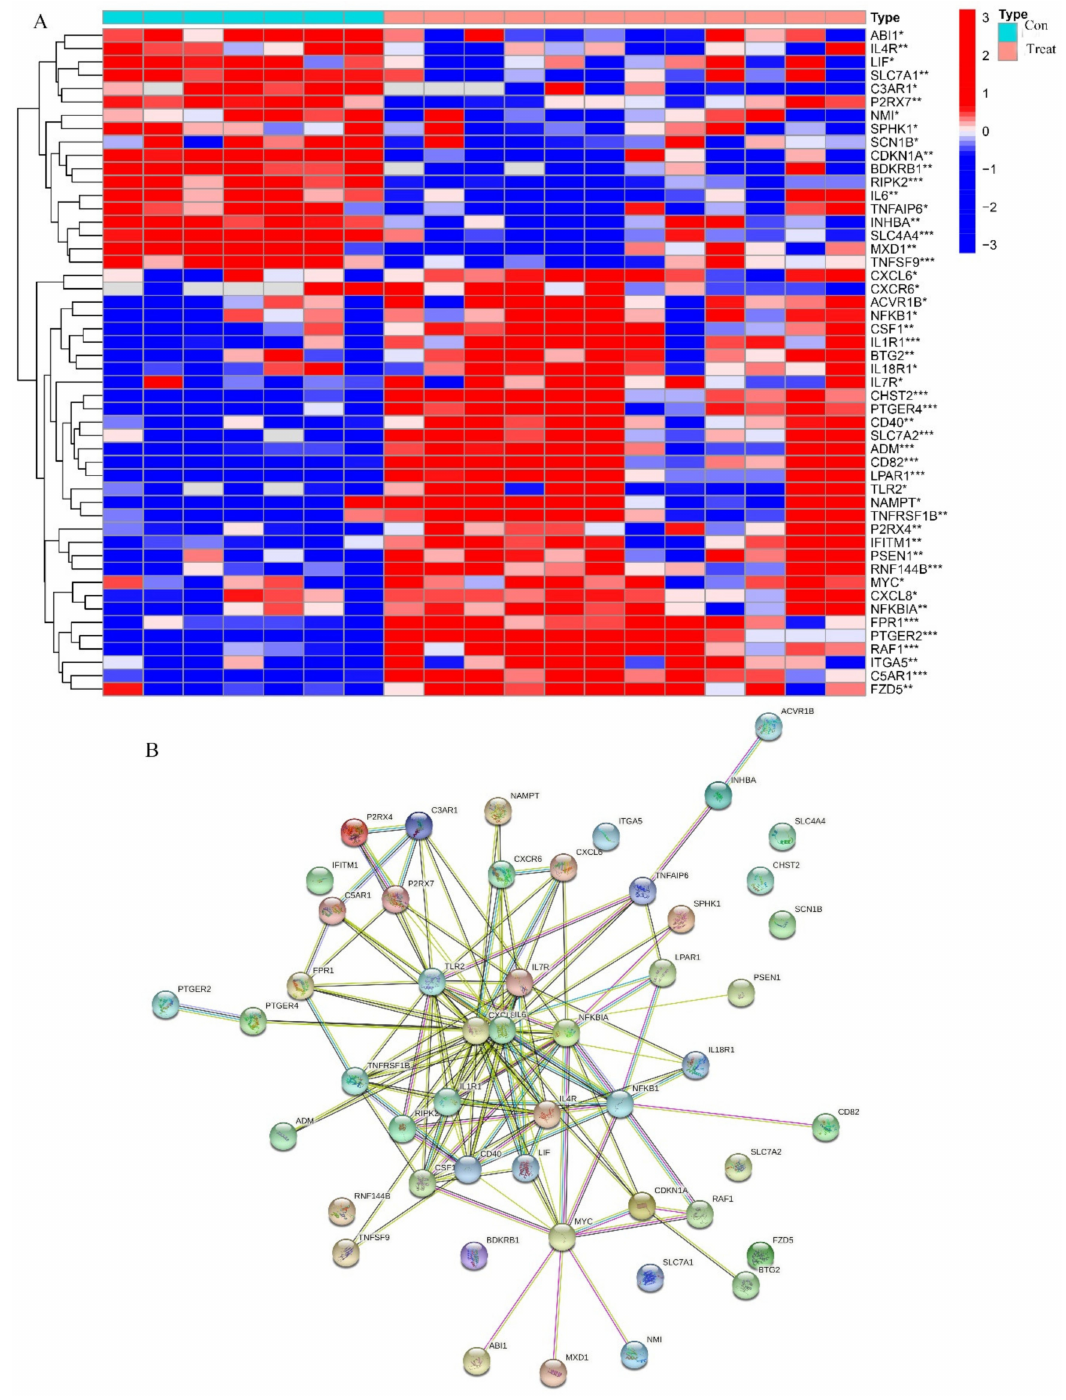
Figure 9. The expression characteristics of inflammation related regulators. ( A ) Heatmaps pre- sented the expression of inflammation related regulators in treat and control group. p < 0.05 (“*”), p < 0.01 (“**”) and p < 0.001 (“***”). ( B ) The STRING Protein − Protein Interaction Networks of inflam- mation related